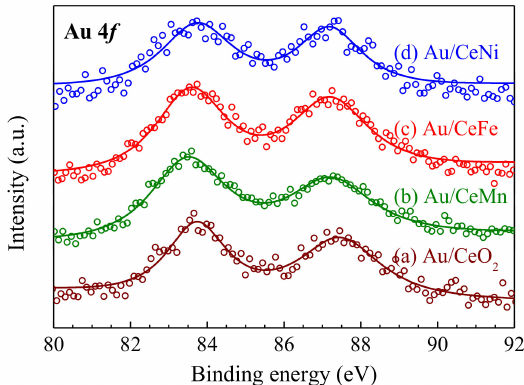
Figure 7. Au 4 f XPS spectra of Au catalysts supported on CeO 2 and CeM mixed oxides with different dopants: ( a ) Au/CeO 2 ; ( b ) Au/CeMn; ( c ) Au/CeFe; ( d )